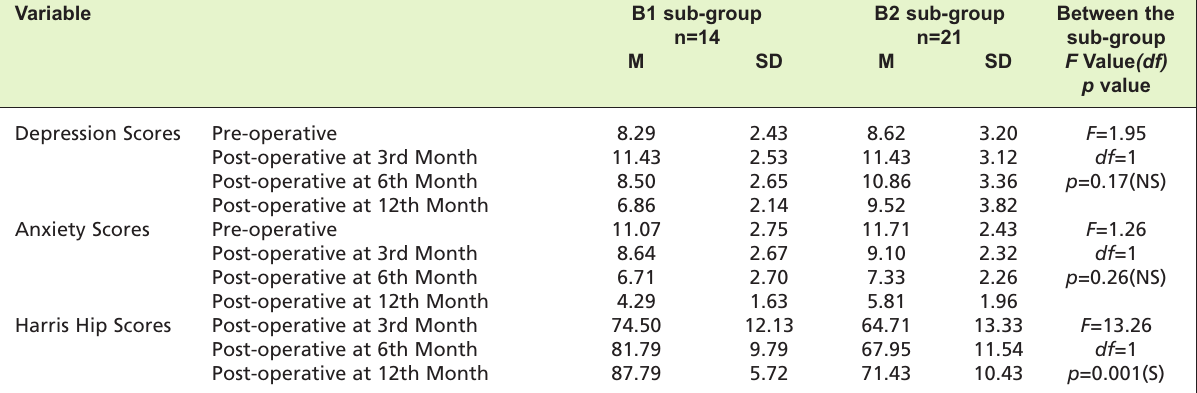
Repeated measures of ANOVA on psychological status (depression, anxiety scores) and functional outcome (Harris Hip Table V: Scores) among participants in B1 sub-group and B2 sub-group at all-time points